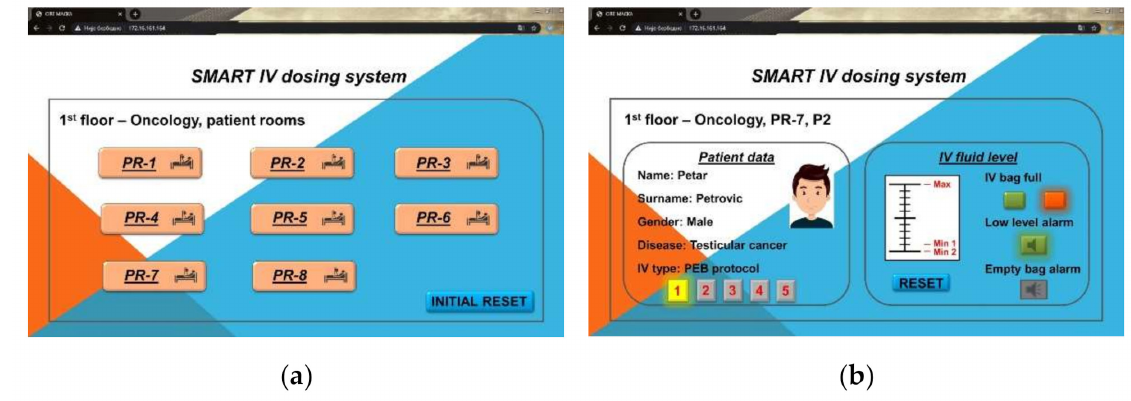
Figure 6. Web application: ( a ) home screen layout; ( b ) screen layout for the selected